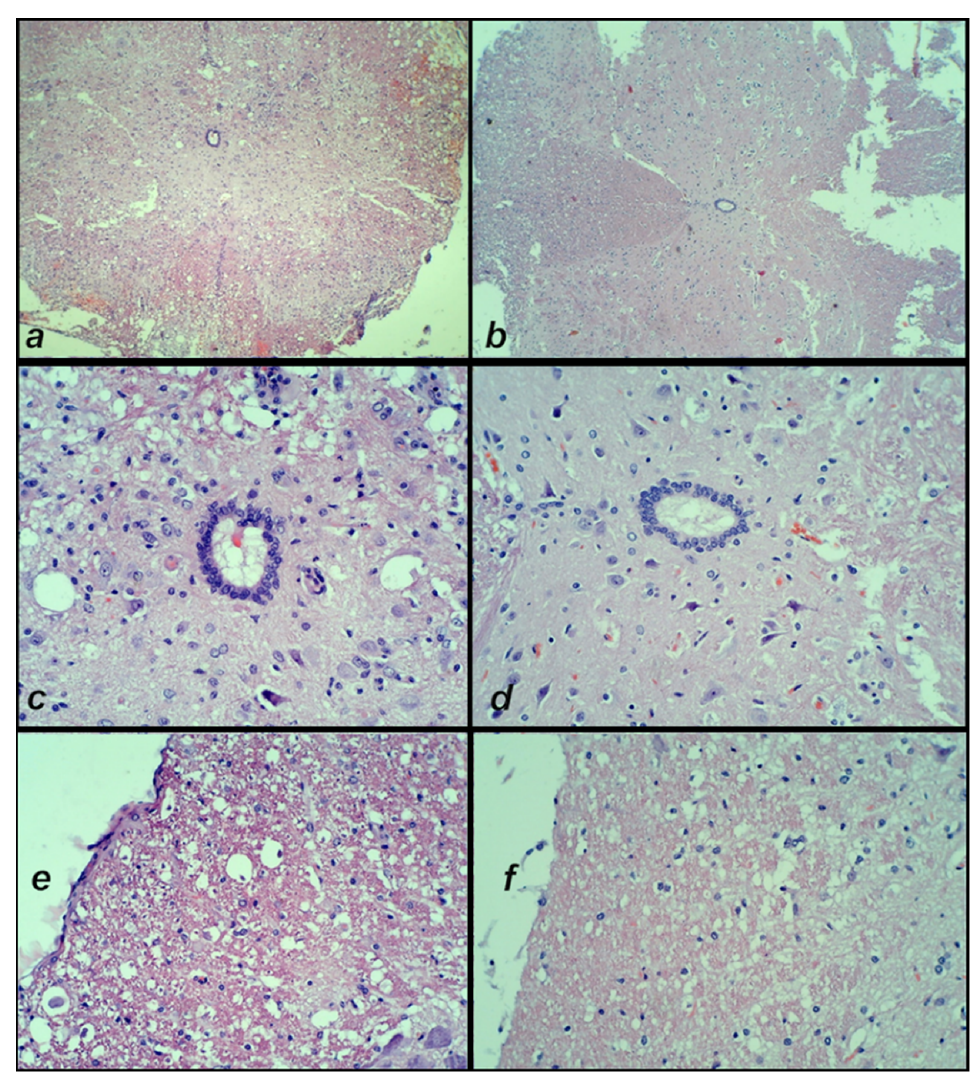
Figure 12. Post-injury day 4 at 20 min following the application of medication. Neuropathological changes in the posttraumatic spinal cord in the anterior horn and the intermediate grey matter at the lesion site. ( a ) Control rats with a large hemorrhagic area, ( c , e ) edema and confluent vacuolation of tissue matter in the anterior horn and intermediate grey matter. ( b ) Mild hemorrhage area in the lateral column and ( d , f ) the mild edema and discrete vacuolation of tissue matter in the anterior horn and intermediate grey matter in the BPC 157 rats. (HE staining; magnification 40 × and 400 × ). (iii). Control. At day 30 post-injury, histochemical staining using Luxol fast blue showed a loss of myelin fibers of the posterior and lateral spinal column tracts, along with the anterior horn, and intermediate grey matter at the lesion site in the controls. BPC 157. Contrarily, BPC 157 rats presented no demyelination process (Figures 13 and